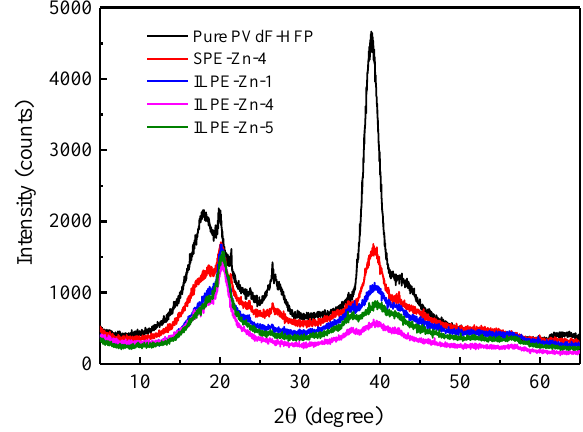
Figure 2. XRD patterns of ILPE membranes with different EMITf contents.